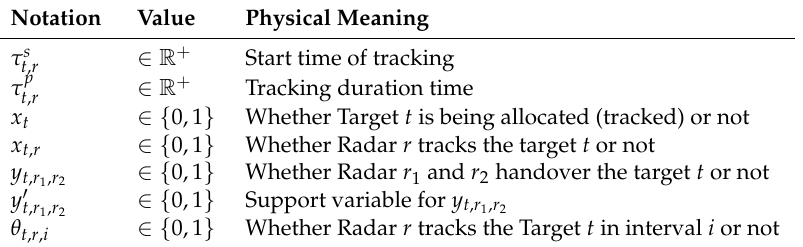
Table 2. List of decision